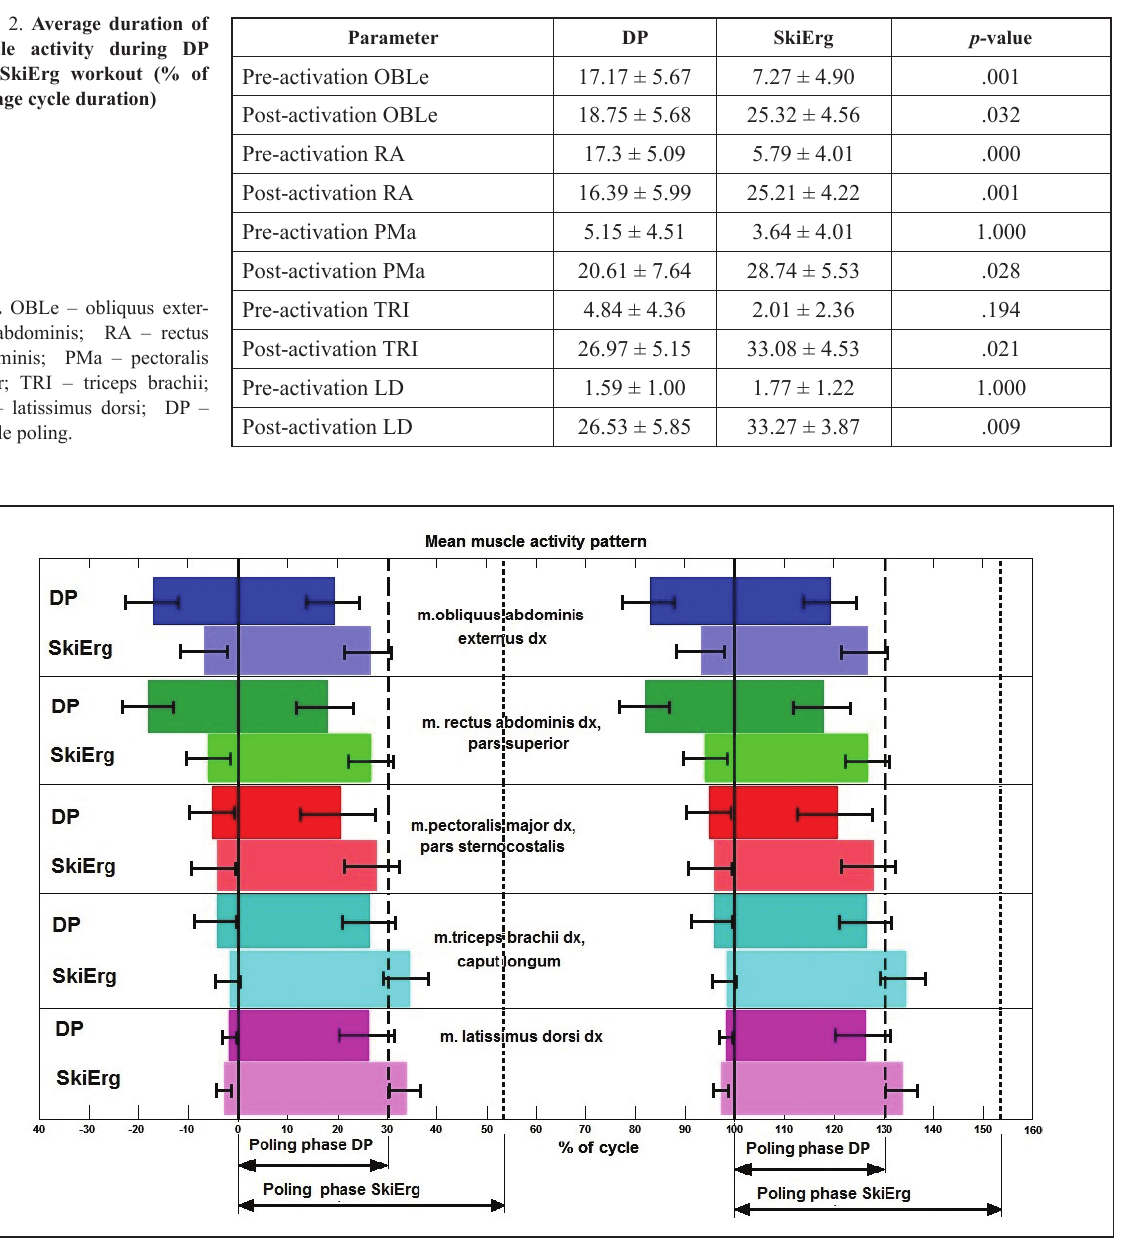
Figure 2. Relative activation time of selected muscles during DP and SkiErg workout in two average